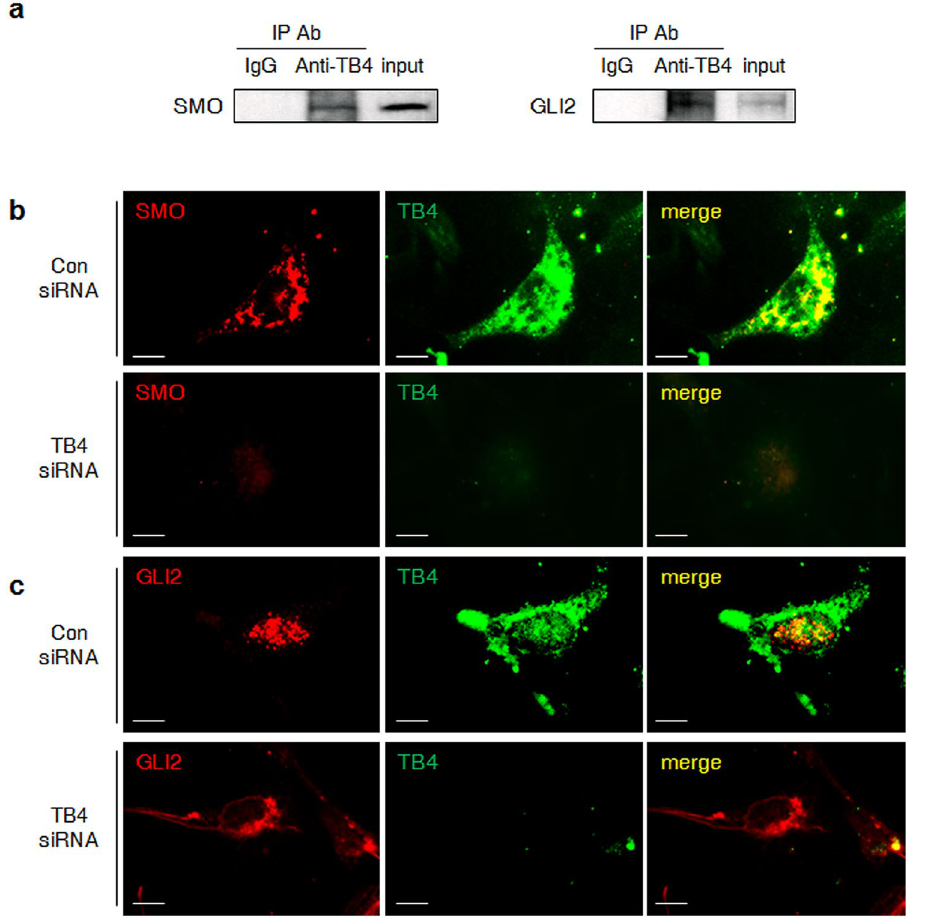
Figure 3. TB4 interacts with either SMO or GLI2 in activated HSCs. ( a ) Immunoblot with SMO or GLI2 in the immunoprecipitated LX-2 lysates with TB4. LX-2 cells were immunoprecipitated with IgG as negative control. 10% of total LX-2 lysates was loaded as input controls. ( b , c ) Double immunofluorescent staining for TB4 with SMO ( b ) or GLI2 ( c ) in Con siRNA- or TB4 siRNA-transfected LX-2 cells ( × 100). Representative images from three experiments with similar results are shown (Scale bar, 20 μ